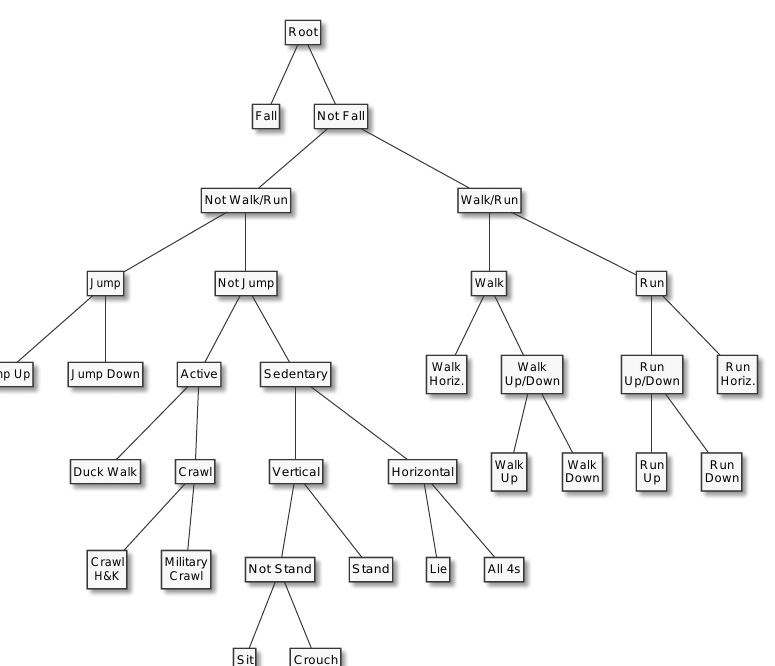
Figure A1. Expert hierarchy 1 (EH1).